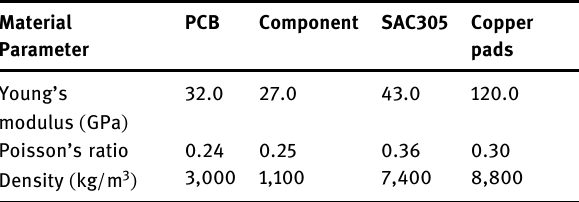
Figure 2: Finite element